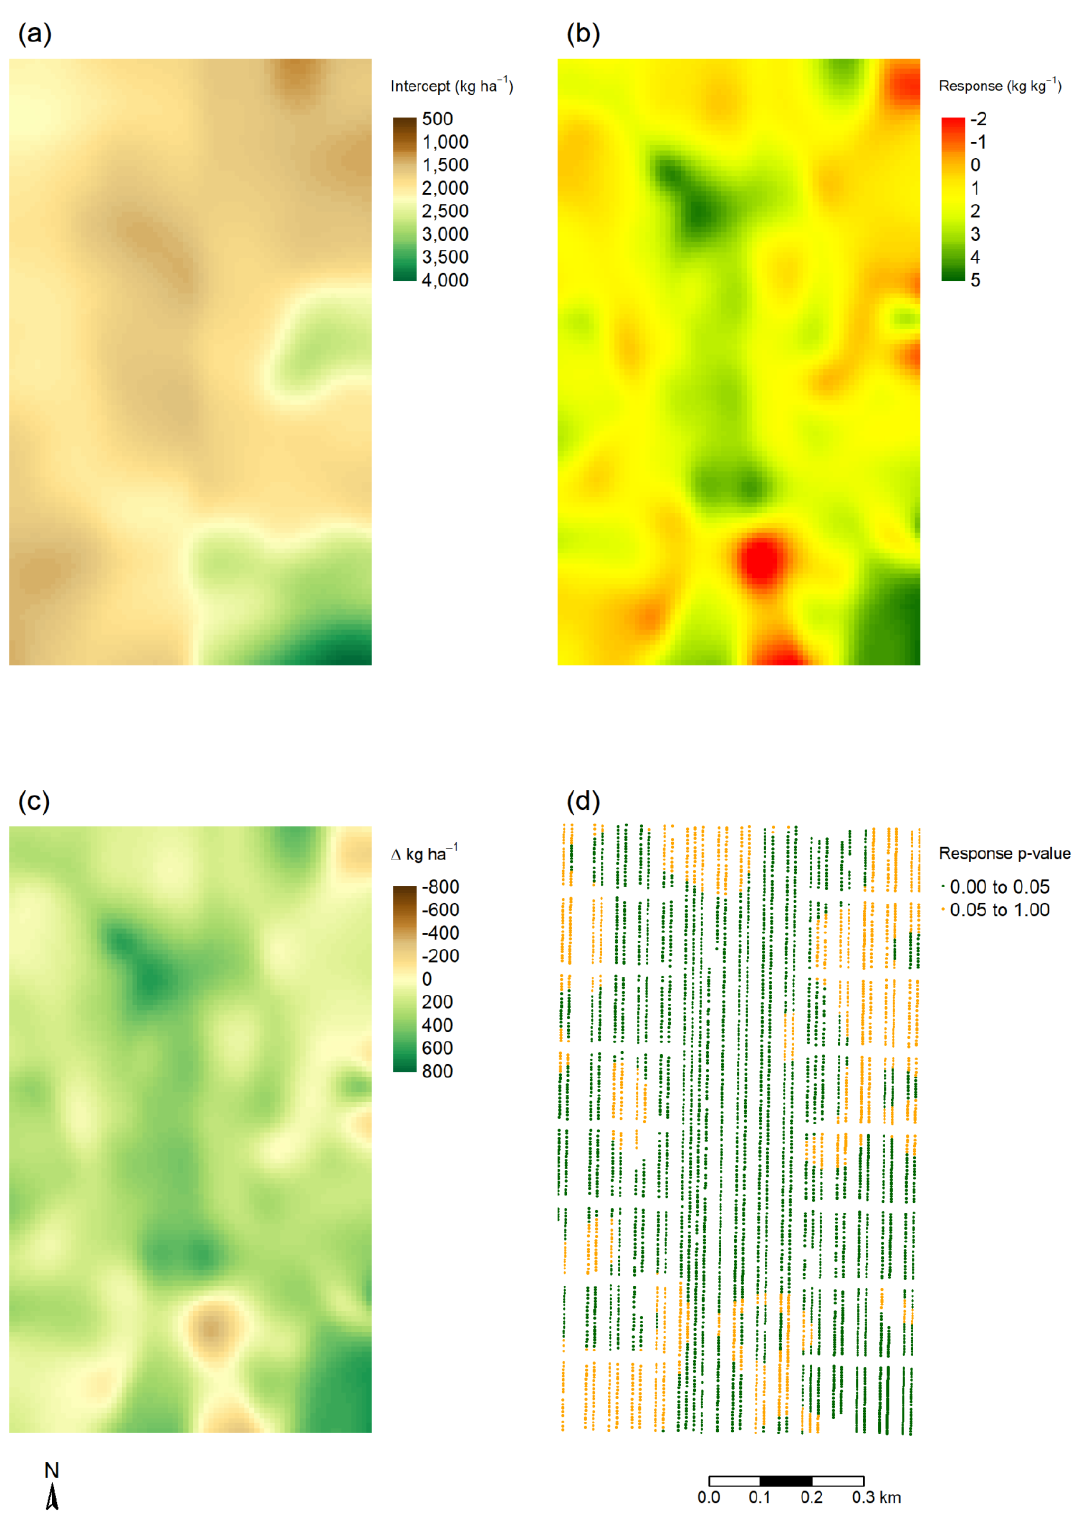
Figure 11. Results of GWR applied to the Narambeen trial: ( a ) yield intercept (kg ha − 1 ); ( b ) response (kg yield kg − 1 MOP); ( c ) predicted change in yield when 134 kg ha − 1 MOP is applied; and ( d ) adjusted p -values of the estimated response coloured such that green areas are significant at the 0.05 probability level.